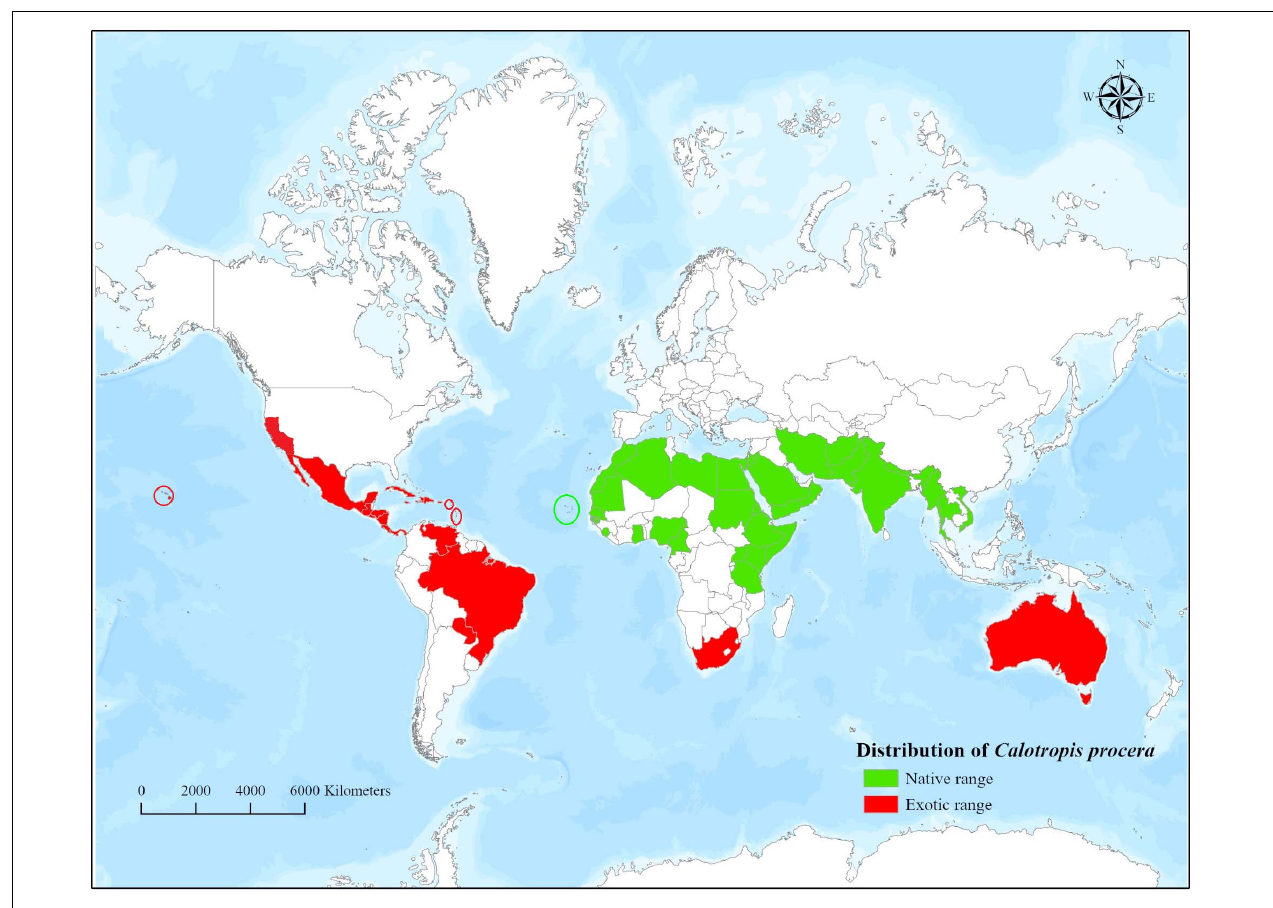
FIGURE 1 | Worldwide distribution of Calotropis